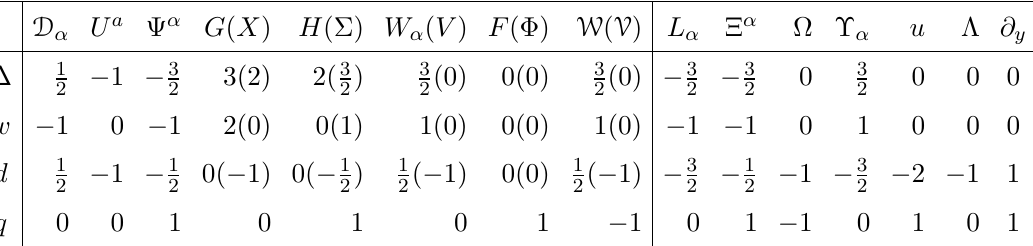
Table 1 . The various Z -gradings of the (cid:12)elds and gauge parameters: scaling dimension (cid:1), U(1) R weight w , mass dimension d , and 5-charge q (with q = p for p -forms, q = (cid:0) 1 for vectors, etc.). the gravitino super(cid:12)eld corrections to the supergeometry: the graviton transformation